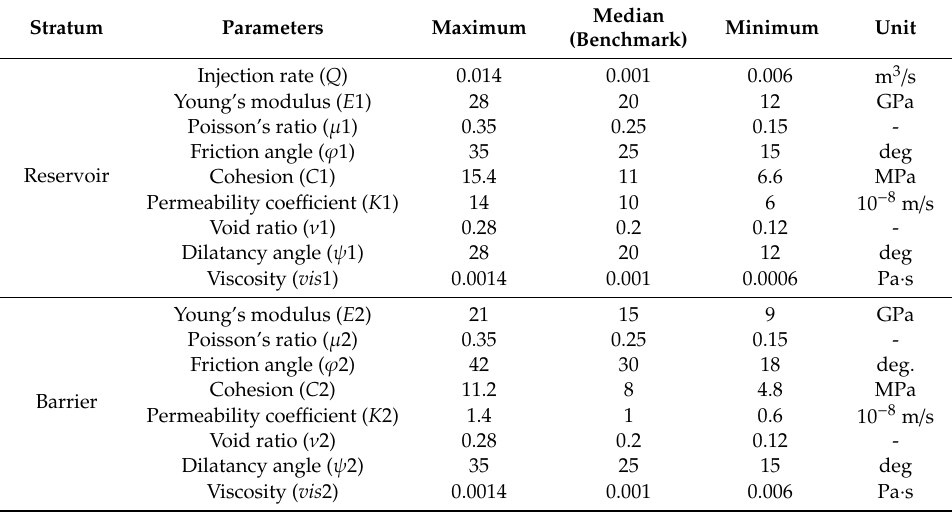
Figure 4. Contrast between the full three-level factorial design and the Box–Behnken design. Blue points and lines, located on a hypersphere equidistant from the central point, represent different experiments of Box–Behnken design for three variables. Together with black points and lines, the full three-level factorial design is described. Table 2. Multiple parameters for experimental design.